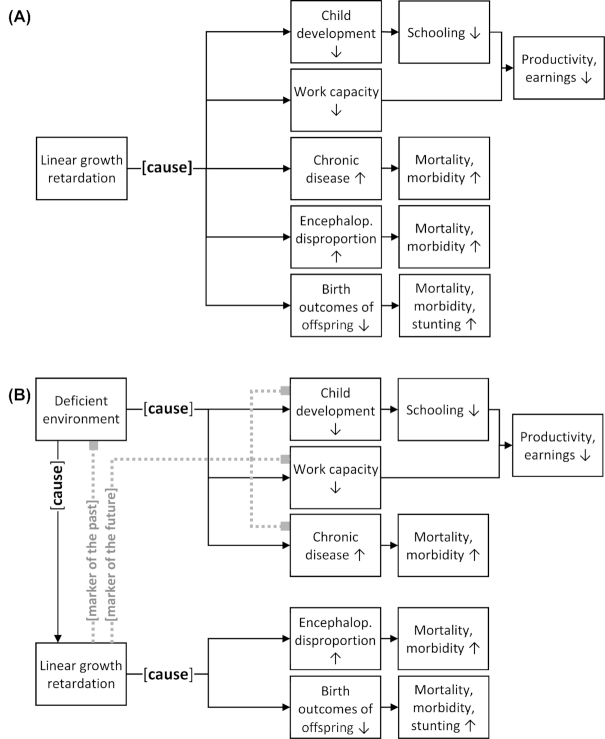
Commonly accepted framework showing the importance of linear growth retardation (A); and proposed framework distinguishing between child linear growth as an indicator reflective of the past, as indicator predicting the future, and as an outcome in its own right (B).